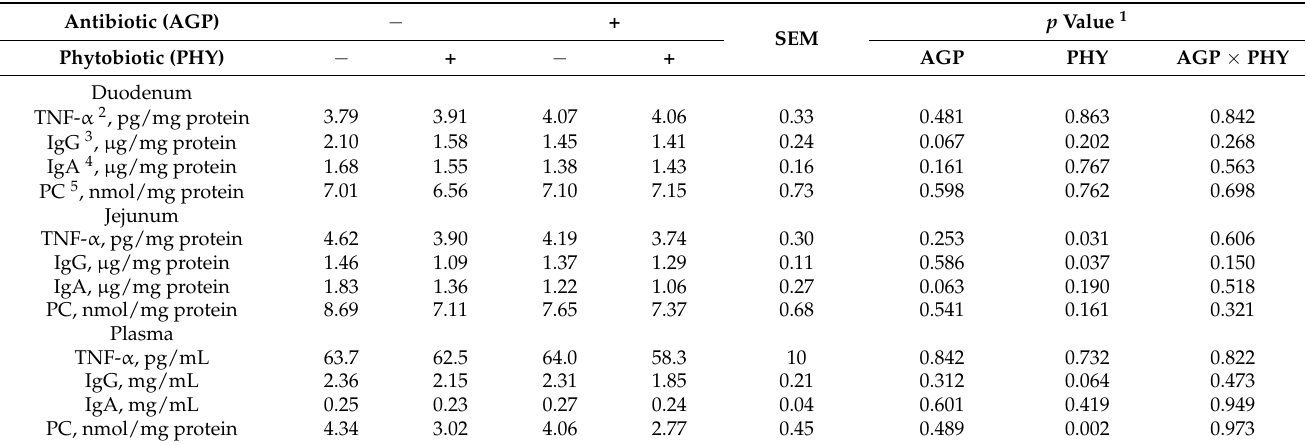
Table 5. Inflammatory and oxidative stress status in the jejunum of nursery pigs fed diets supple- mented with phytobiotics and antibiotics as growth promoters (Exp. 1).